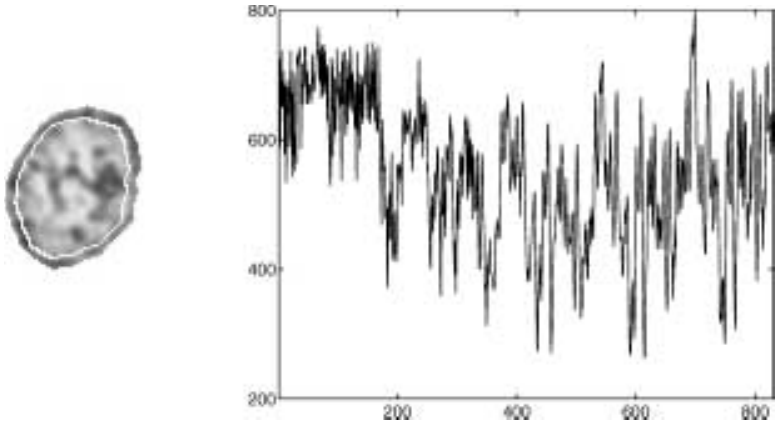
Fig. 3. Left: A cell nucleus from a good prognosis sample. The border between the 30% peripheral and 70% central part is outlined as a thin white line. Right: The 1D gray level signal corresponding to the peripheral part of the 2D nuclei image. The nucleus is selected from a histological